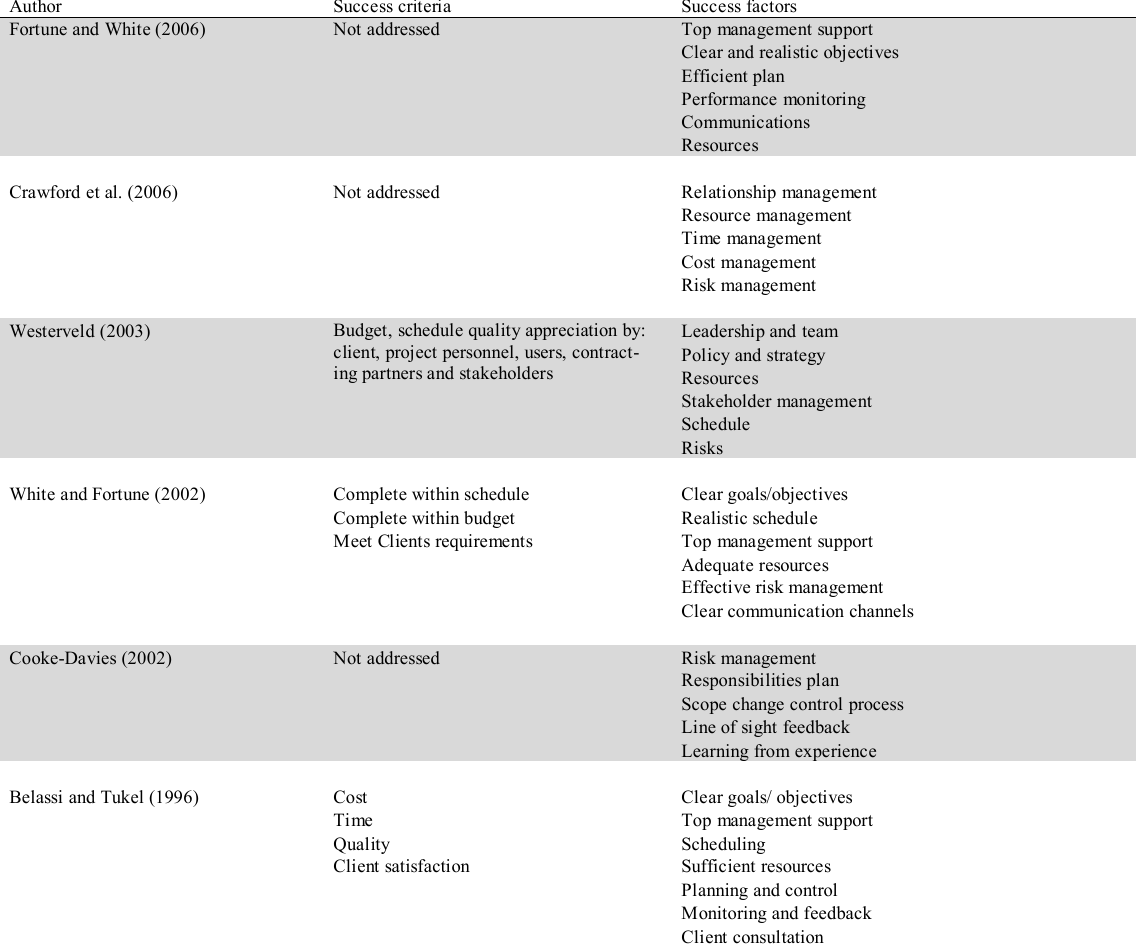
Table 1 Review of success criteria and success factor adapted from (Murphy & Ledwith, 2007)